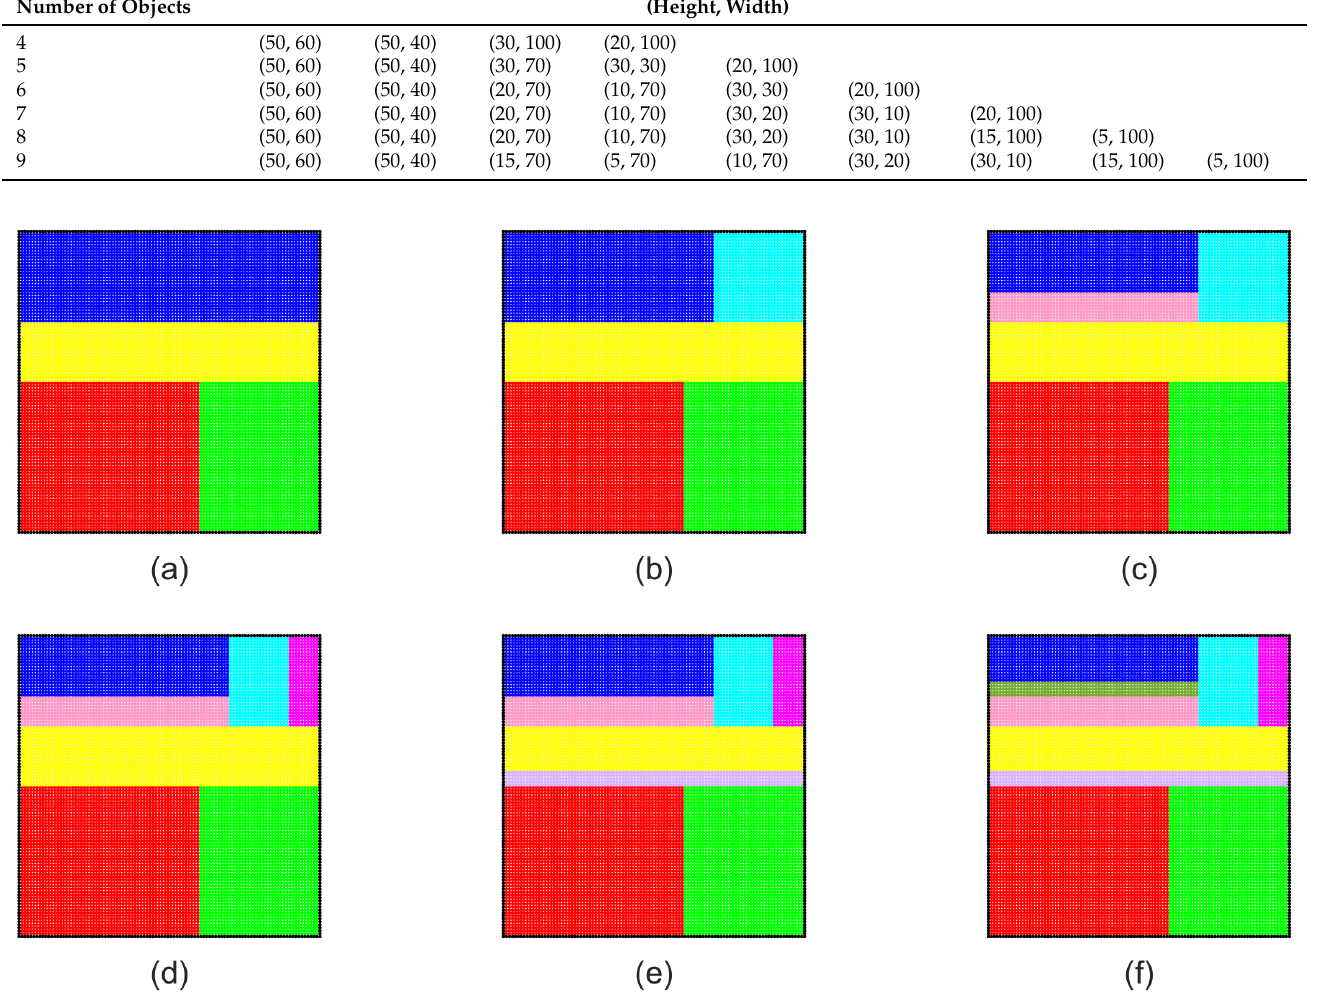
Figure 5. Sample optimal solutions for different sets of rectangles used in the first study with restrained rotations. When packed optimally the objects perfectly fill the domain and their number in the sets increases from ( a – f ) as one rectangle is split into two new ones at each